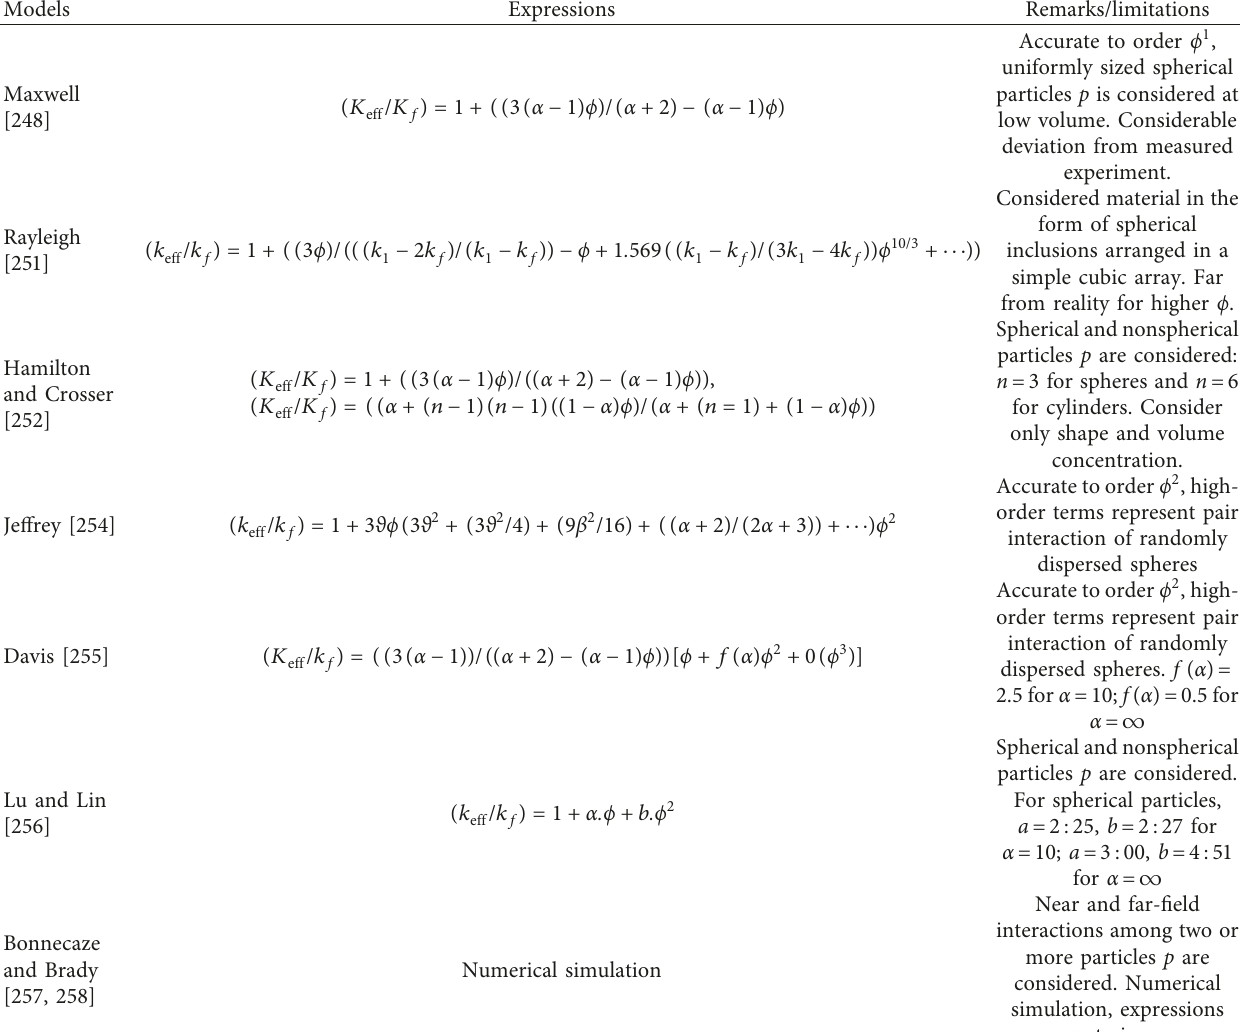
, thermal conductivity of base fluid k f , thermal conductivity of particle